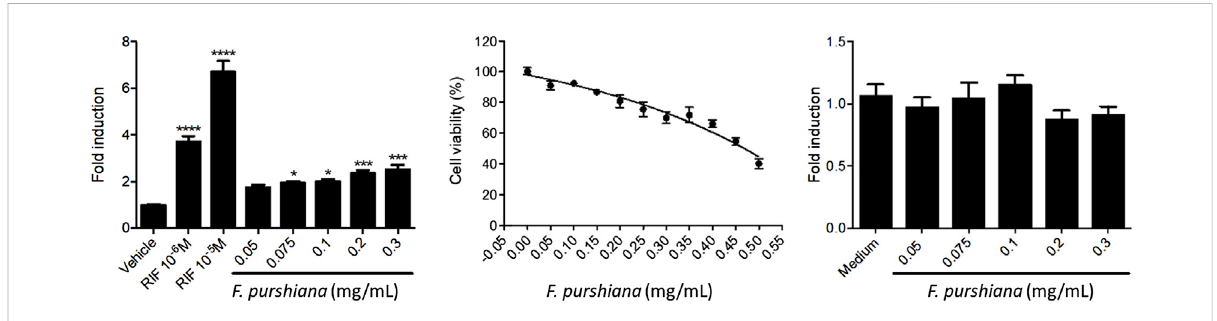
FIGURE 5 Effects of Frangula purshiana on (left) the activation of hPXR in transiently transfected HeLa cells and Rifampicin (RIF, positive reference), (centre) cell viability in the same cell line and (right) expression vector pCMV luciferase reporter in co-transfected HeLa cells. (Mean ± SEM, n ≥ 3 Statistical signi fi cance against DMSO 0.2% (control) according to Bonferroni (* p < 0.05, ** p < 0.01, *** p <